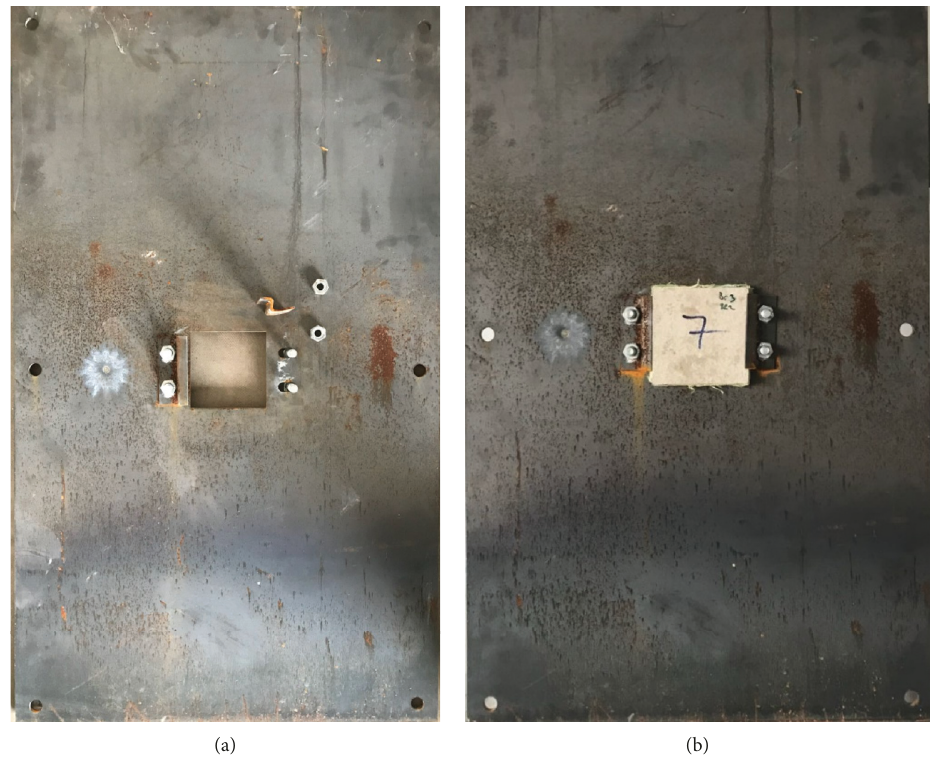
Figure 2: An image of the metal board (50 × 84 × 3 mm) and Z-shaped